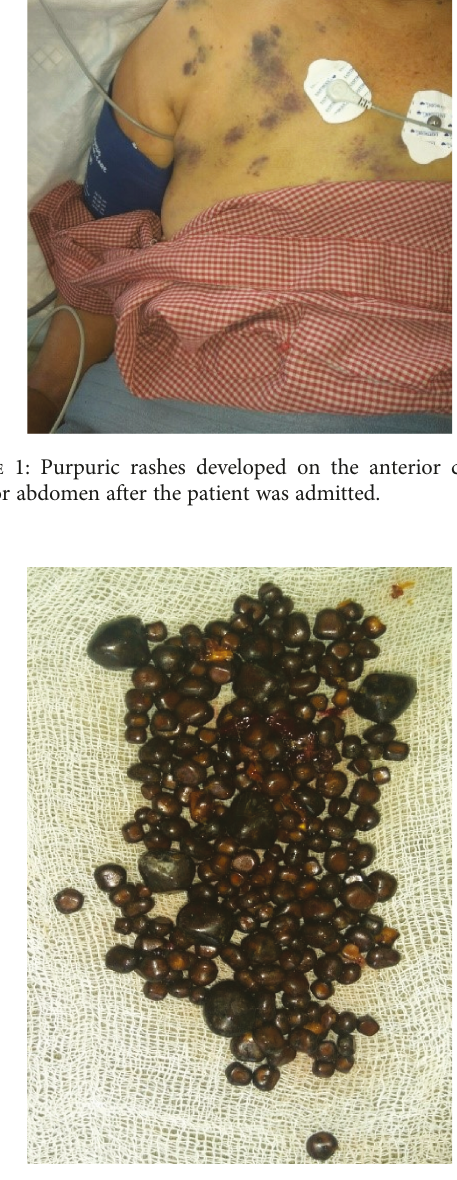
Figure 2: Laparoscopic cholecystectomy revealed multiple small calculi inside the